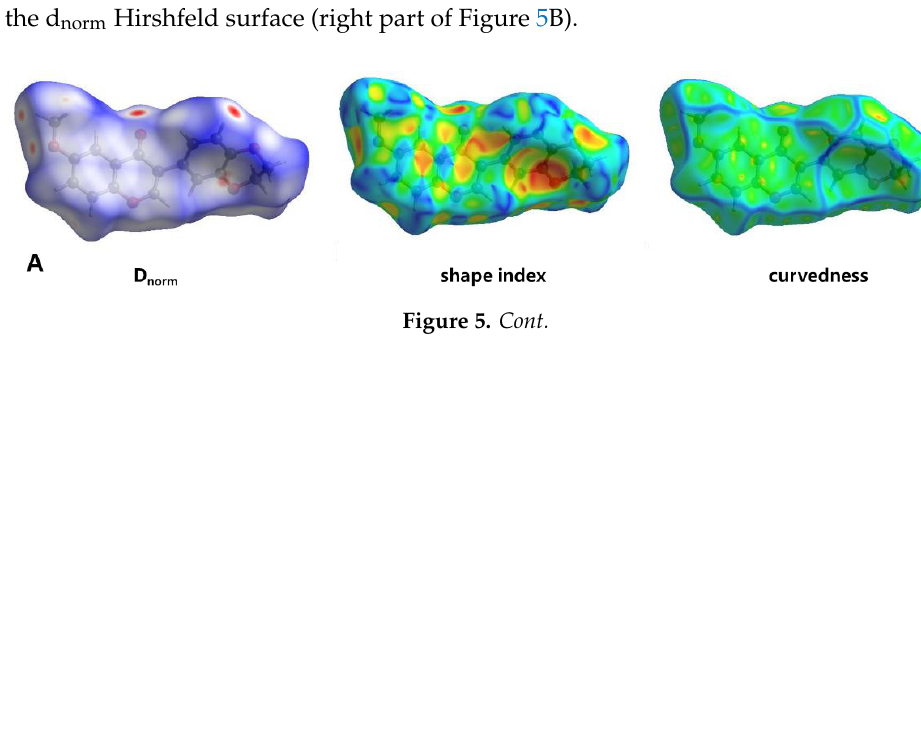
Figure 4. Intermolecular hydrogen bonds lead the molecules along c-axis ( A ) and multiple intermolecular hydrogen bonds stabilize crystal packing by a three-dimensional network ( B ). Table 3. Intermolecular hydrogen bonds for isoflavone 6 [Å and °].